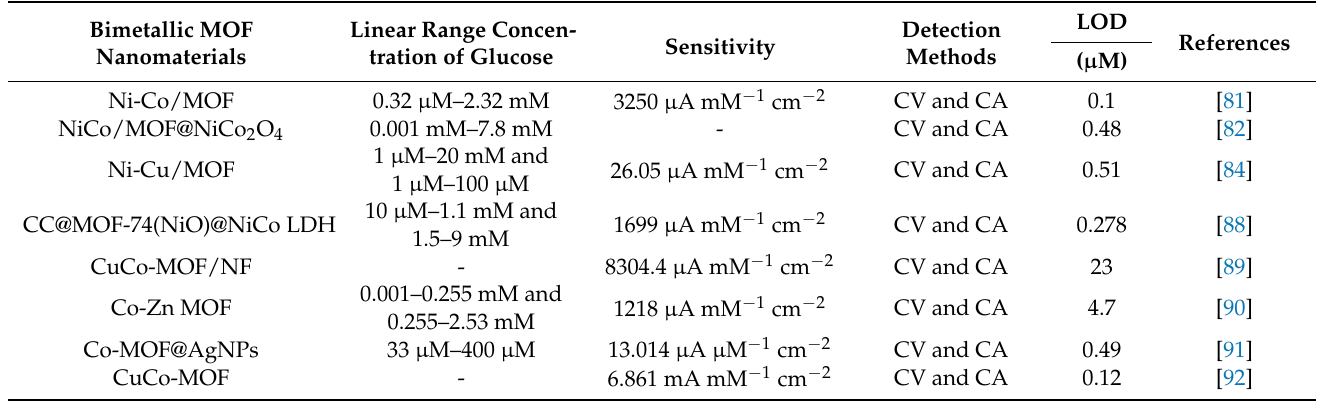
Table 3. Bimetallic MOF nanomaterials based glucose sensor fabrication schemes and their analyti- cal